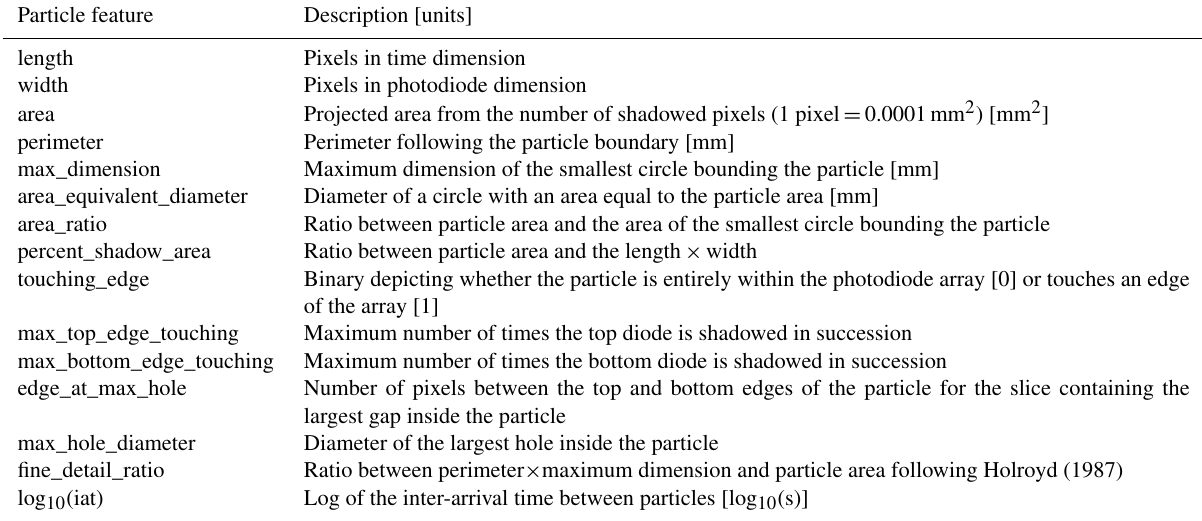
Table 1. Description of particle features used in UWILD. Features have units of numbers of pixels except where different units are specified.